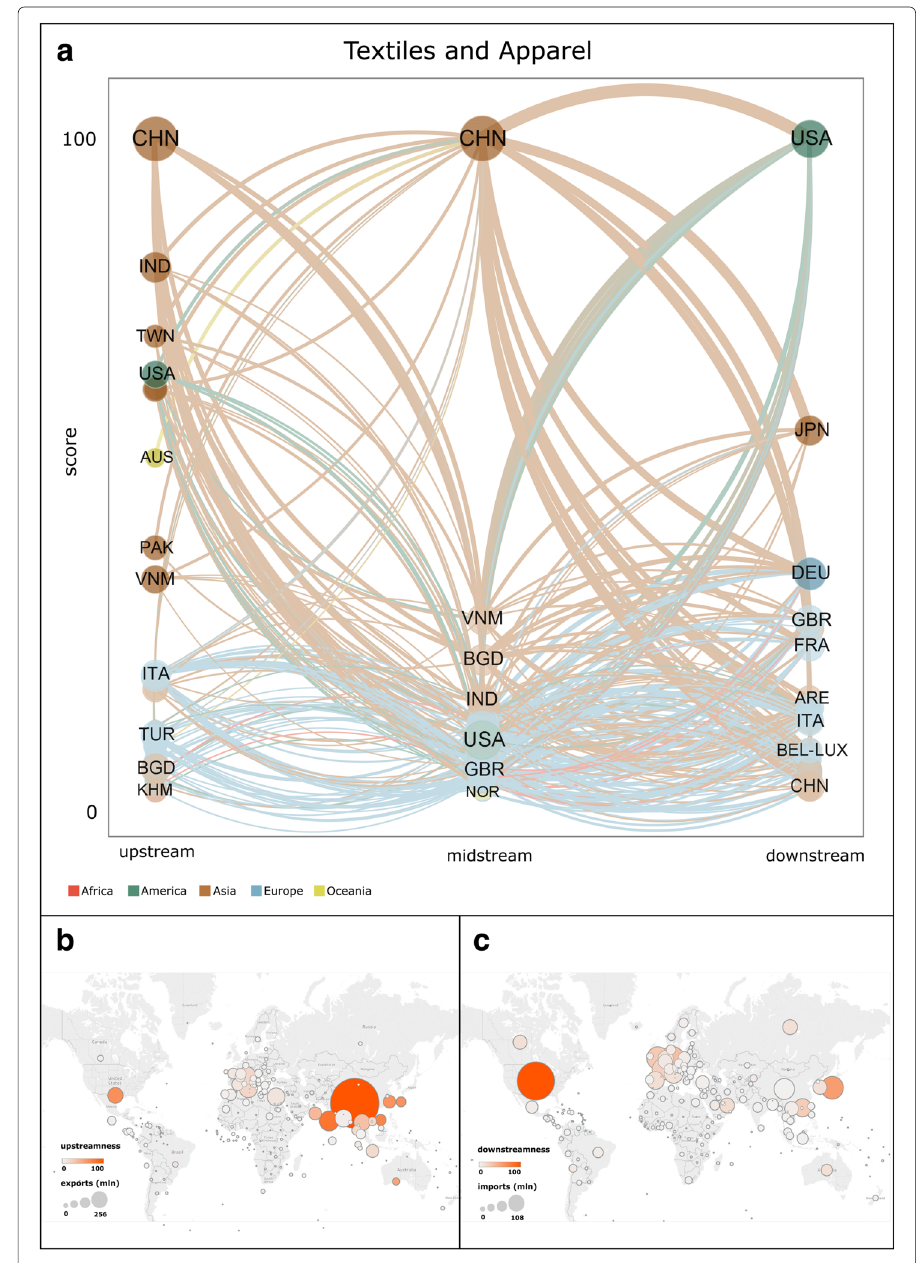
Fig. 7 Rankings and values of upstreamness centrality, midstreamness centrality, downstreamness centrality, exports, and imports of countries in the Textiles and Apparel industry in 2014. In panel ( a ), the size of each node (country) in the network is proportional to the sum of the country’s exports of intermediate inputs (upstream), the sum of the country’s imports of intermediate inputs and exports of final products (midstream), and the sum of the country’s imports of final products (downstream). For each centrality measure, countries are ranked according to the corresponding score (highest at the top). Each directed link connects a country in set U to a country in set M , or a country in set M to a country in set U , according to the definition of the tripartite network given in the text. The width of each link is proportional to the value of products exchanged by the two connected countries. The colour of each link refers to the continent of the country from which the link originates. Panels ( b ) and ( c ) show the geographic map in which each country is represented as a circle whose diameter is proportional to the country’s total exports (panel ( b )) and total imports (panel ( c )), and whose colour varies according to the corresponding value of upstreamness (panel ( b )) and downstreamness (panel ( c )) centralities. The network in panel ( a ) was visualised through VOS Viewer. Maps in panels ( b ) and ( c ) were visualised using Tableau